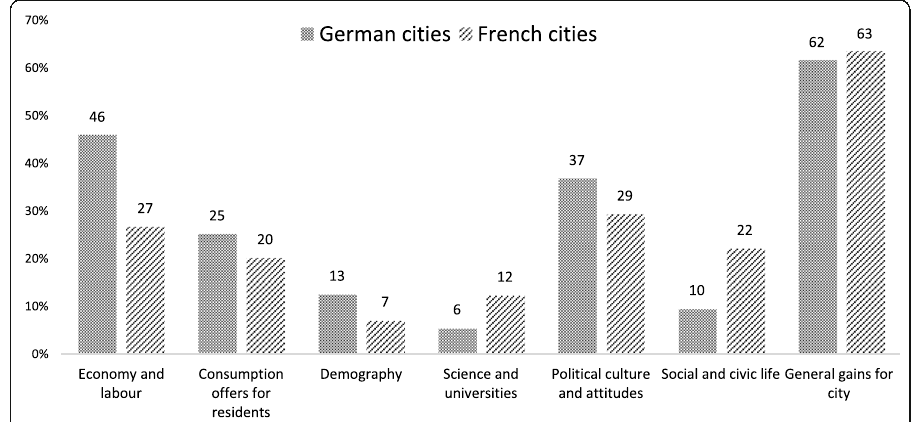
Fig. 1 Perceived benefits of diversity for the cities. Source: CityDiv Survey, N (German cities) = 396, N (French cities)=